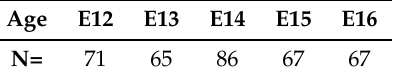
Table 5. Sample sizes for each embryological age. Each embryo was collected at 9:00 a.m. on the designated embryological